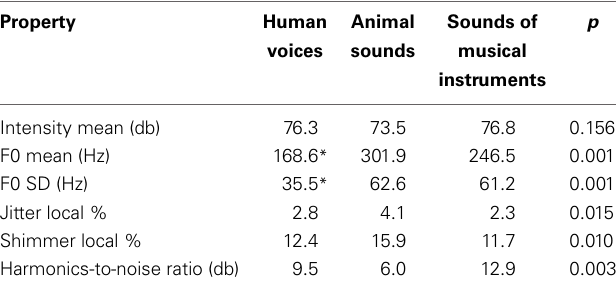
Table 1 | Acoustic properties of the three stimulus